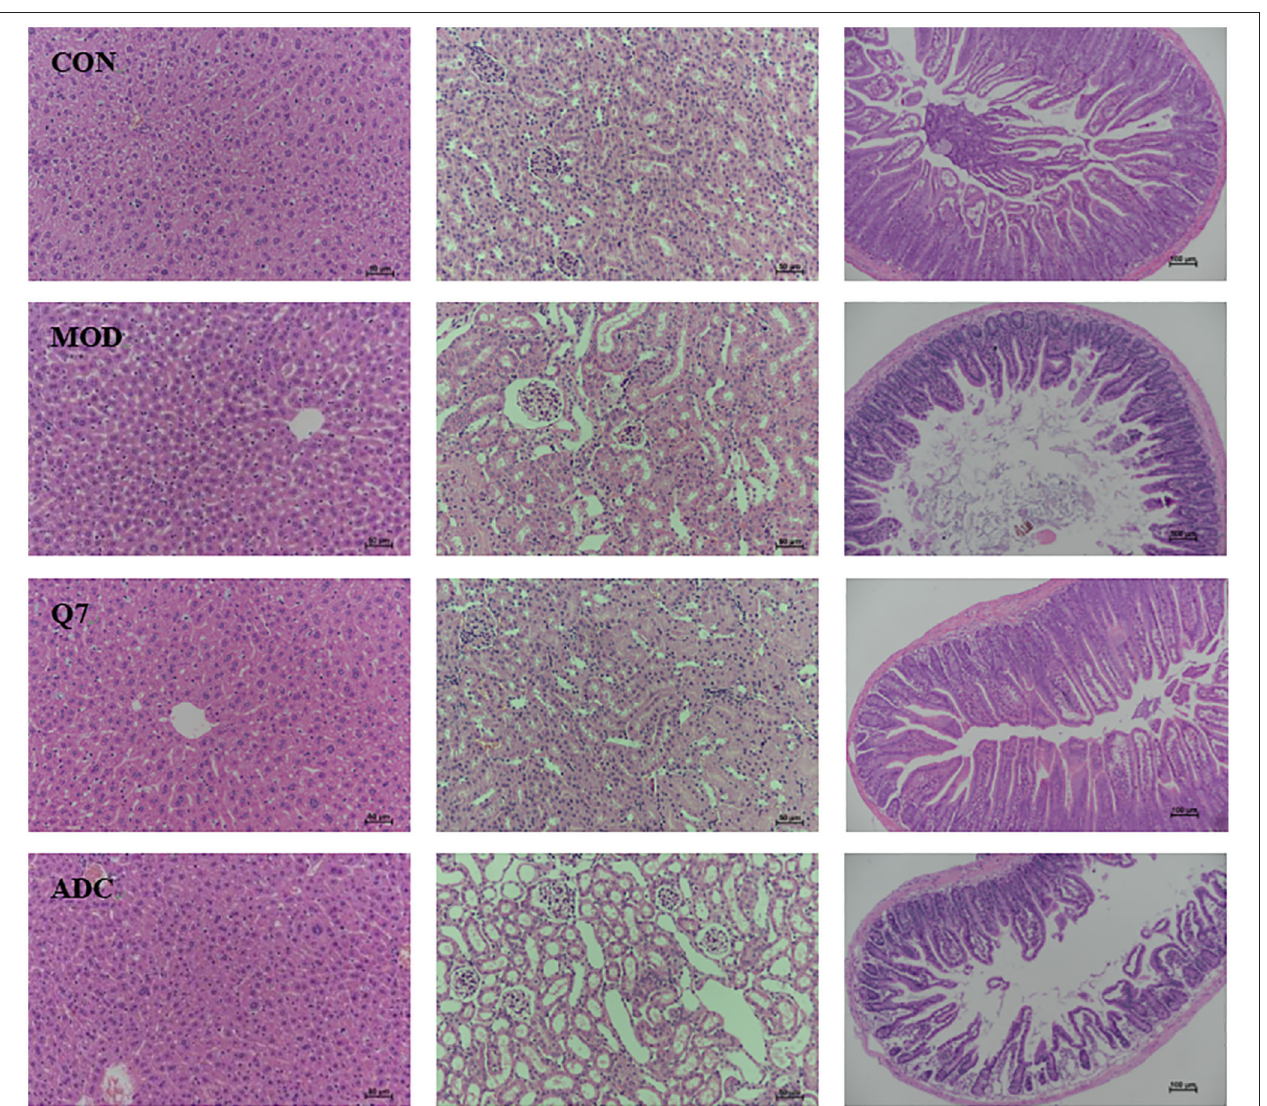
Frontiers in Nutrition |